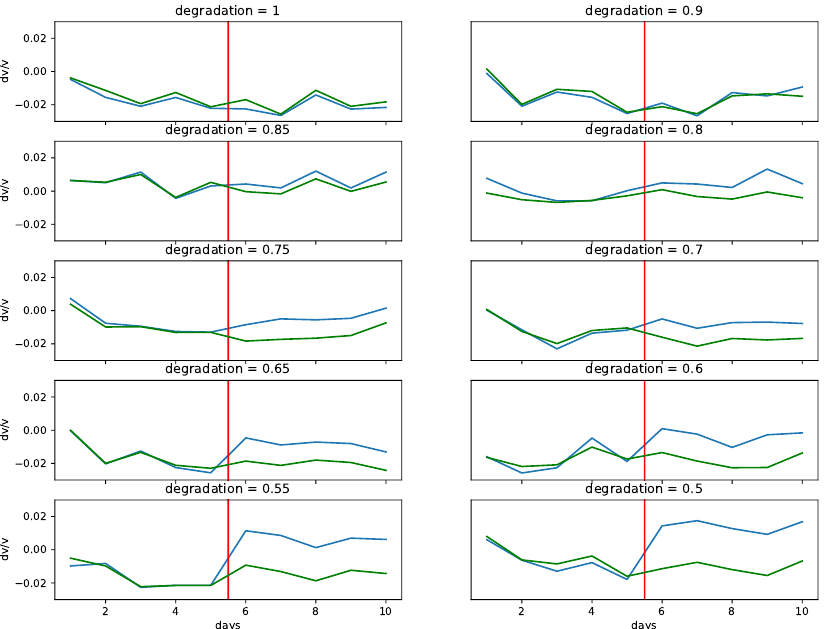
Figure 6. Examples of the first (green) and second (blue) natural modes for different degradation coefficient values. The red vertical line indicates the day on which the damage occurs. For the first natural mode, it becomes quite challenging to distinguish damage from variations due to temperature for examples with a degradation coefficient larger than 0.6. The second natural mode does not show any measurable variation in ∆ ν / ν because the damage is located near one of the nodes of the second natural mode (see Figure 7—red